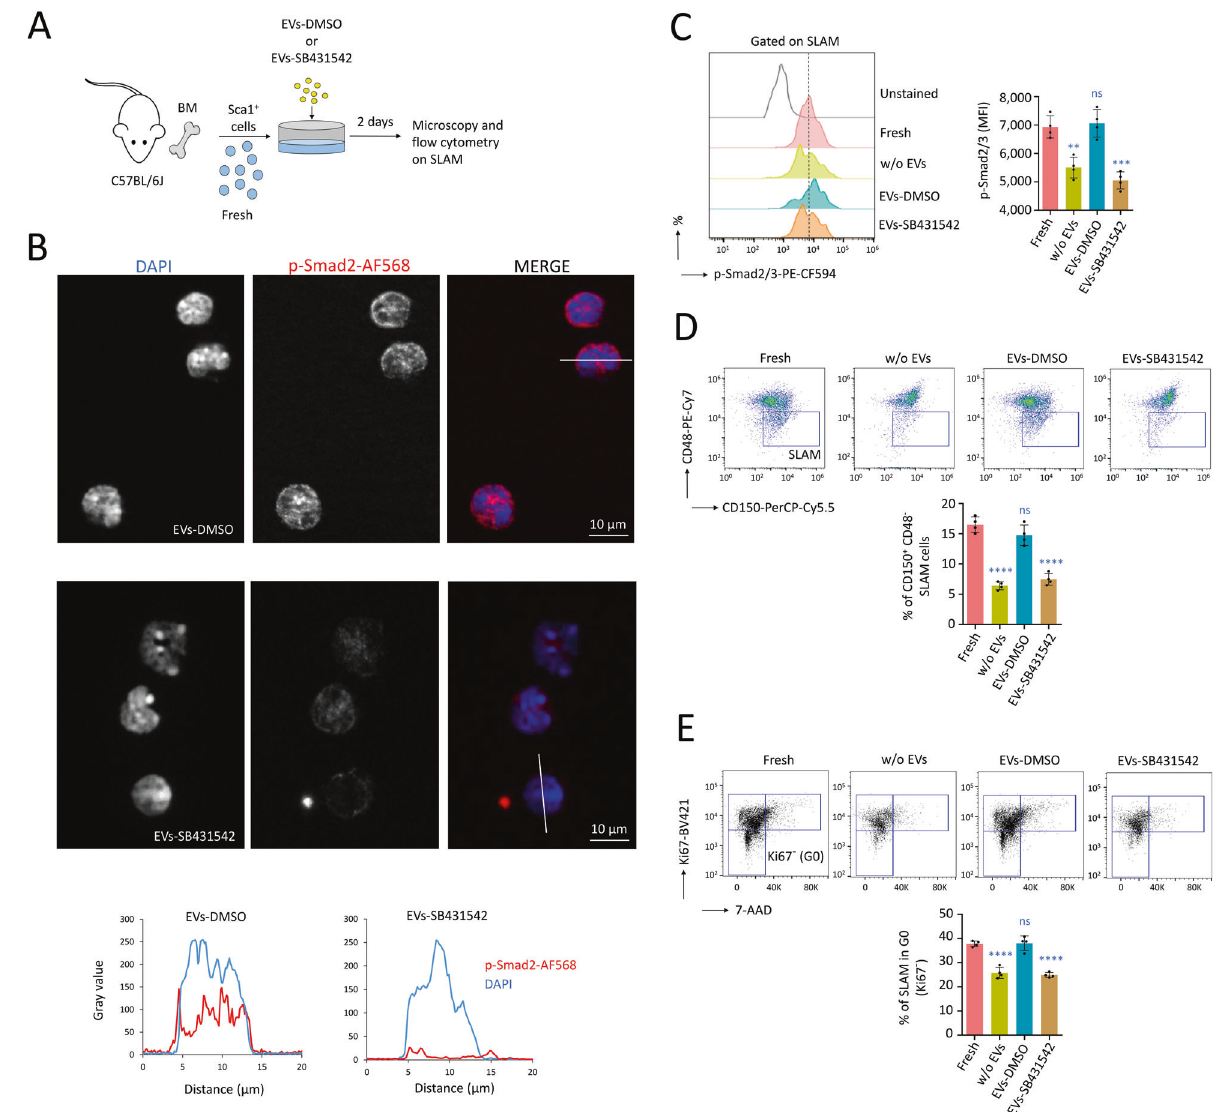
Fig. 5 MS-5-EVs carrying p-Smad2 allow maintenance of HSC ex vivo. A Procedure followed to maintain Sca1 + HSC freshly (fresh) isolated ex vivo, with MS-5-EVs carrying p-Smad2 or not due to a treatment of MS-5 cells with SB431542. We administered 10 9 particles per 4 × 10 5 Sca1 + cells for 48 h. B Fluorescent optical sections, showing high level of p-Smad2 in the nucleus of HSC after incubation with EVs-DMSO, while HSC treated with EVs-SB431542 showed a low intracellular level of p-Smad2. Magni fi cation ×63, white scale bar corresponds to 10 µm, white bars correspond to the sections for measurement of p-Smad2 and DAPI fl uorescence. PKH67 + SLAM cells were puri fi ed by FACS. C Flow cytometry on HSC (SLAM cells) after permeabilization showing that treatment with EVs-DMSO maintained p-Smad2/3 levels, while a decrease in active TGF- β signaling was observed with EVs-SB431542, as well as without EVs (w/o EVs). Data normalized to the same number of HSC. D Treatment with EVs-DMSO maintained the number of HSC (SLAM cells) after 48 h, while EVs-SB431542 induced their exhaustion. E Cell cycling activity of HSC, measured by fl ow cytometry after permeabilization, showing maintenance of quiescent HSC (Ki67 - SLAM cells in G0) following treatment with EVs-DMSO, but not with EVs-SB431542. In this fi gure, data are shown as means ± SD, n = 4 mice. P value calculated against the fresh condition and measured by one-way ANOVA with Tukey ’ s multiple comparison test; ** P < 0.01; *** P < 0.001; **** P < 0.0001; ns, non-signi fi